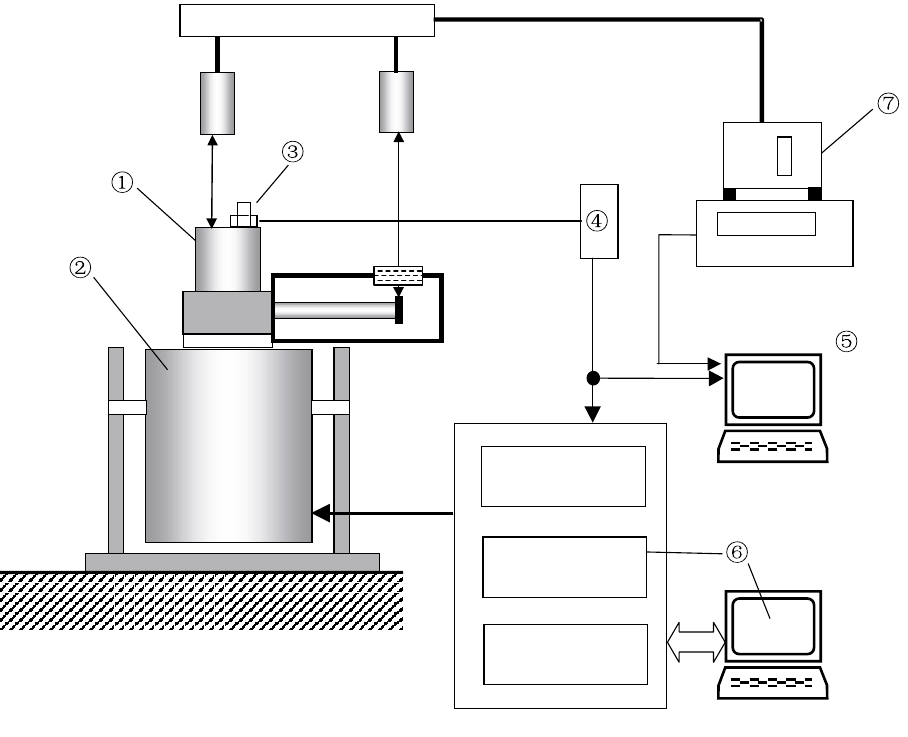
Fig. 6. Schematics of experimental